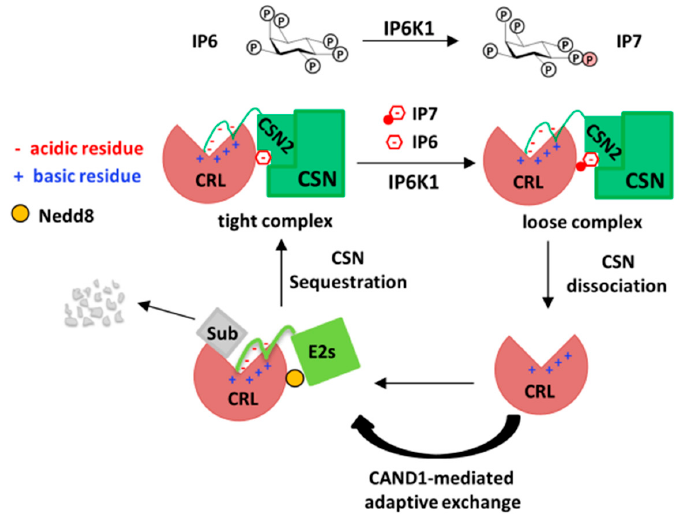
Figure 3. Scheme depicting the role of inositol polyphosphates in the assembly and disassembly of CRL–CSN complexes. Driven by the kinase IP6K1, the CRL–CSN complexes inter-converts between the IP 6 -bridged, high-affinity state and the IP 7 -brdiged, lower-affinity state, with the later prone to dissociation, permitting CAND1-mediated exchange of substrate receptors.